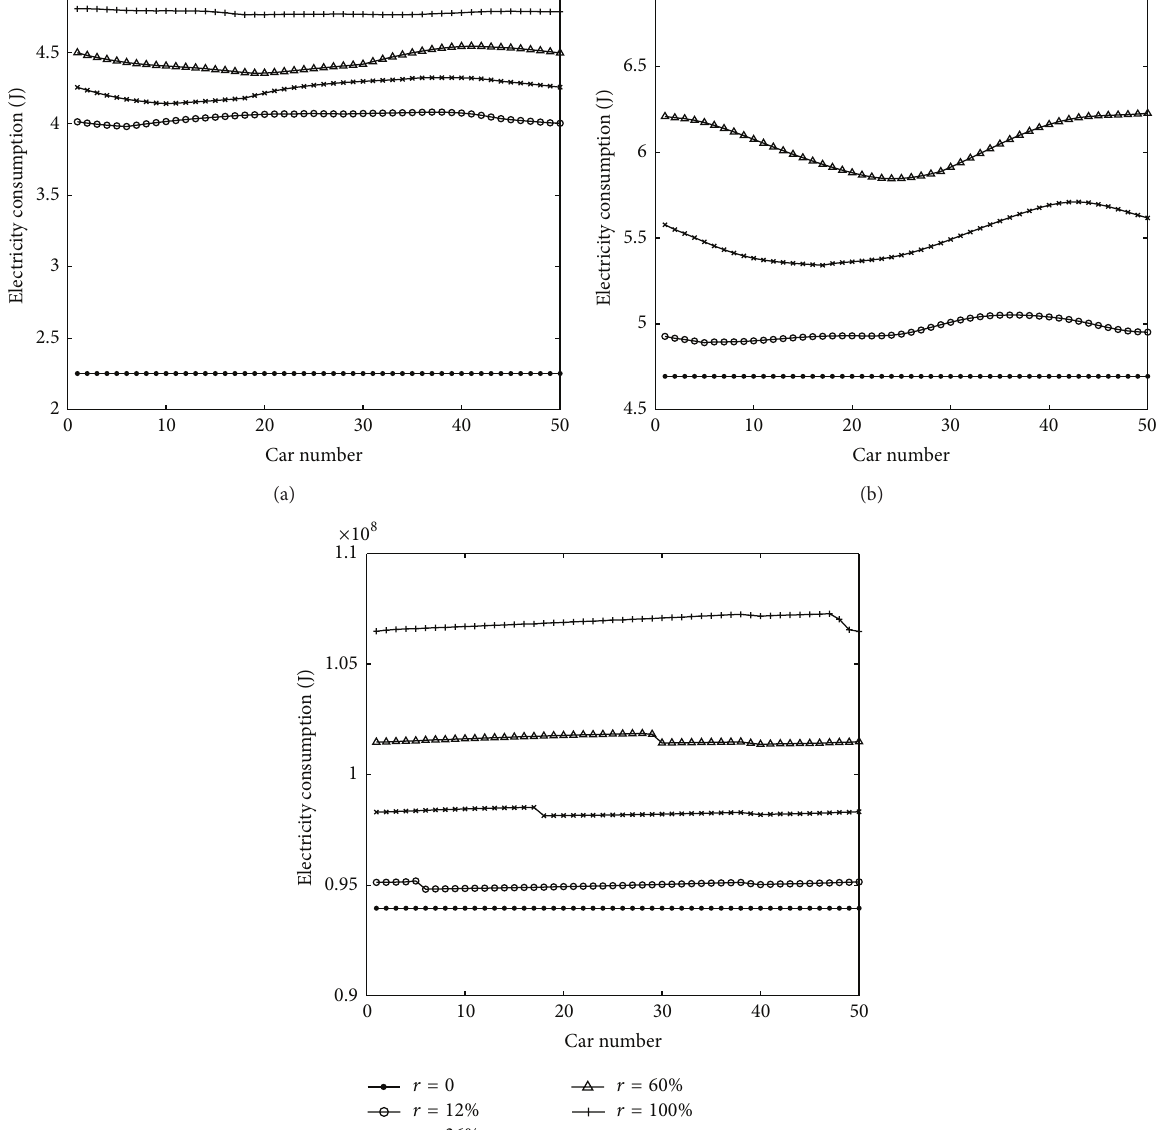
resulted by exchanging battery in this paper); that is, consider the